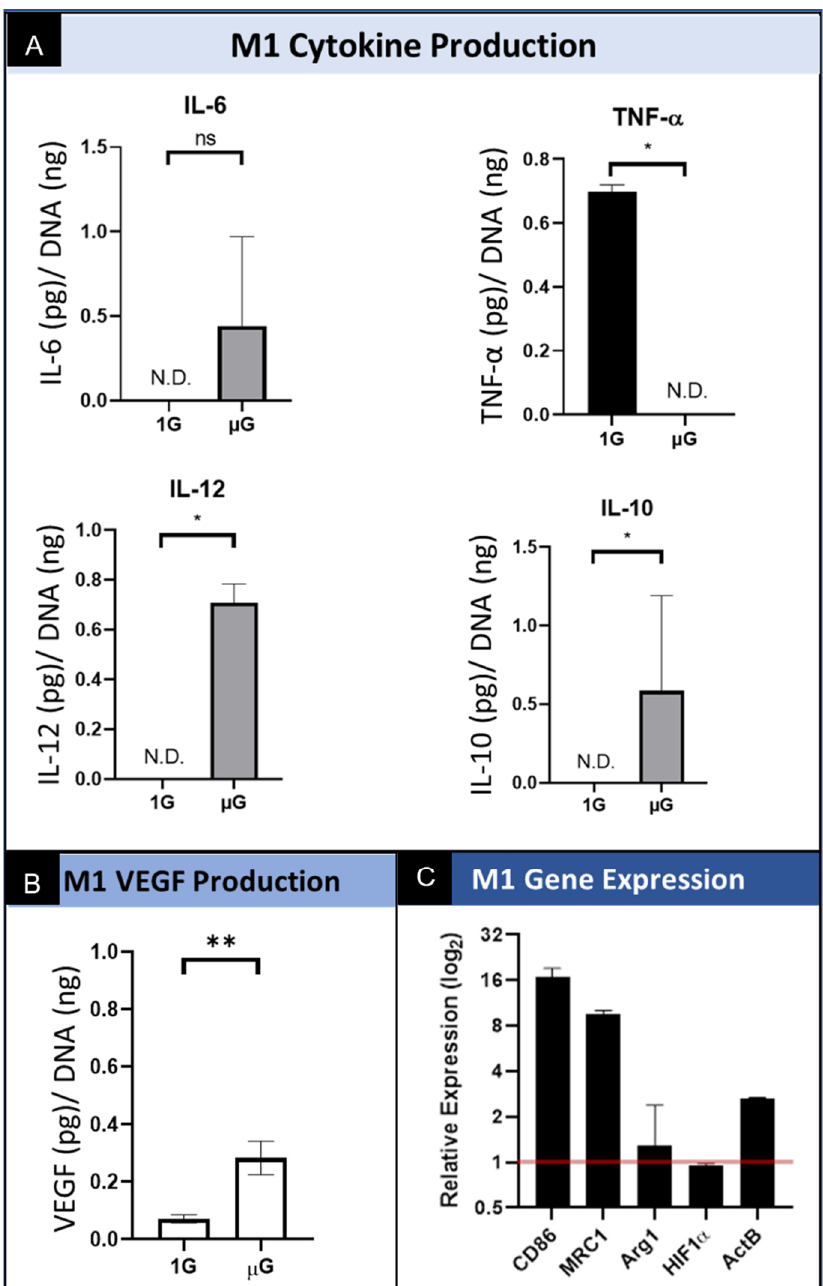
Figure 4. Summary of the effect of simulated microgravity on M1 macrophage protein and gene expression. ( A ) Quantification of M1 macrophage secretion of inflammatory cytokines while cultured in both normal gravity (1G) and simulated microgravity (µG) for IL-6, TNF- α , IL-10, and IL-12. Data normalized to DNA concentration and are presented as Mean +/- SD, n = 3. N.D. indicates Table 1. Significance determined by unpaired Student’s t-test; * denotes p < 0.05; ns denotes non-significant. ( B ) Quantification of VEGF secretion by M1 macrophages cultured in normal gravity (1G) and simulated microgravity (µG). Data normalized to DNA concentration and are presented as Mean +/- SD, n = 3; Significance determined by unpaired Student’s t-test; * denotes p < 0.05; ** denotes p < 0.01. ( C ) Gene expression of M1 phenotype macrophages for M1 specific (CD86) and M2 specific (MRC1 and Arg1) genes, transcription factor, HIF1 α , and structural gene ActB. Data displayed as relative expression of simulated µG samples compared to 1G controls (red line).